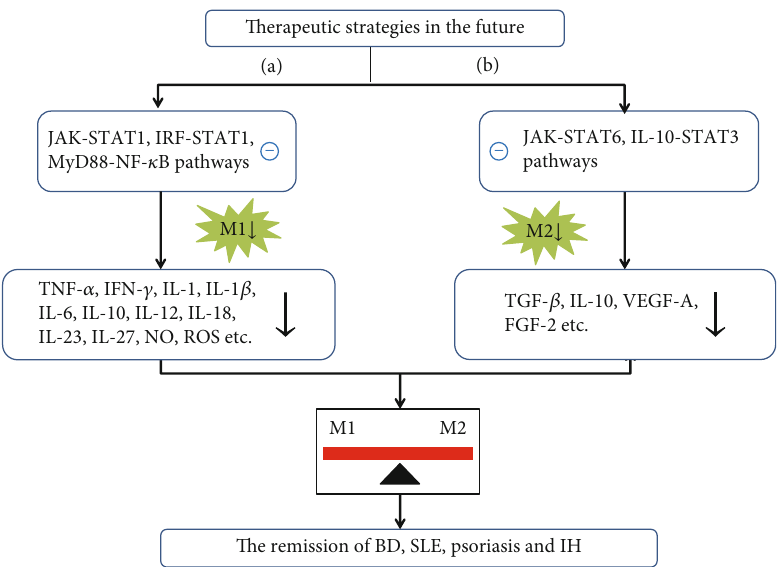
Figure 3: Future directions of treatment for macrophage polarization-mediated dermatosis. (a) Future treatment directions in M1 polarization-mediated skin diseases (BD, SLE, and psoriasis). (b) Future treatment directions in M2 polarization-mediated skin disease (IH). (cid:1)(cid:3) indicates “ inhibition ” and ↓ indicates “ downregulation ” . Abbreviations: JAK: Janus kinase; STAT1/3/6: signal transducer and activator of transcription 1/3/6; IRF: interferon regulatory factor; IL-10: interleukin 10; MyD88: myeloid di ff erentiation factor 88; NF- κ B: nuclear factor kappa B; M1: classically activated macrophage; M2: alternatively activated macrophage; TNF- α : tumor necrosis factor alpha; IFN- γ : interferon gamma; IL-1/1 β /6/10/12/18/23/27: interleukin 1/1 β /6/10/12/18/23/27; ROS: reactive oxygen species; TGF- β : transforming growth factor- β ; NO: nitric oxide; VEGF-A: vascular endothelial growth factor A; FGF-2: fi broblast growth factor 2; SLE: systemic lupus erythematosus; BD: Behcet ’ s disease; IH: infantile